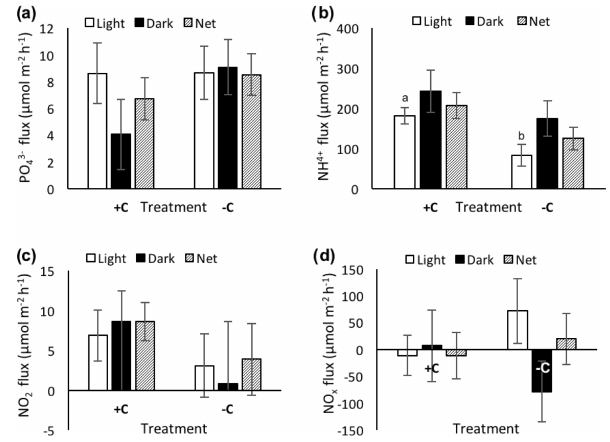
Figure 1. Mean ( ± standard error) net fluxes (in µmolm − 2 h − 1 ; n = 5) of (a) dissolved oxygen (DO), (b) DIC, (c) dinitrogen gas (N 2 ) and (d) gross primary production (GPP) in incubation cham- bers containing sea cucumbers and aquaculture waste with ( + C) or without ( − C) carbon addition, incubated under light and dark con- ditions between day 1 and day 13.